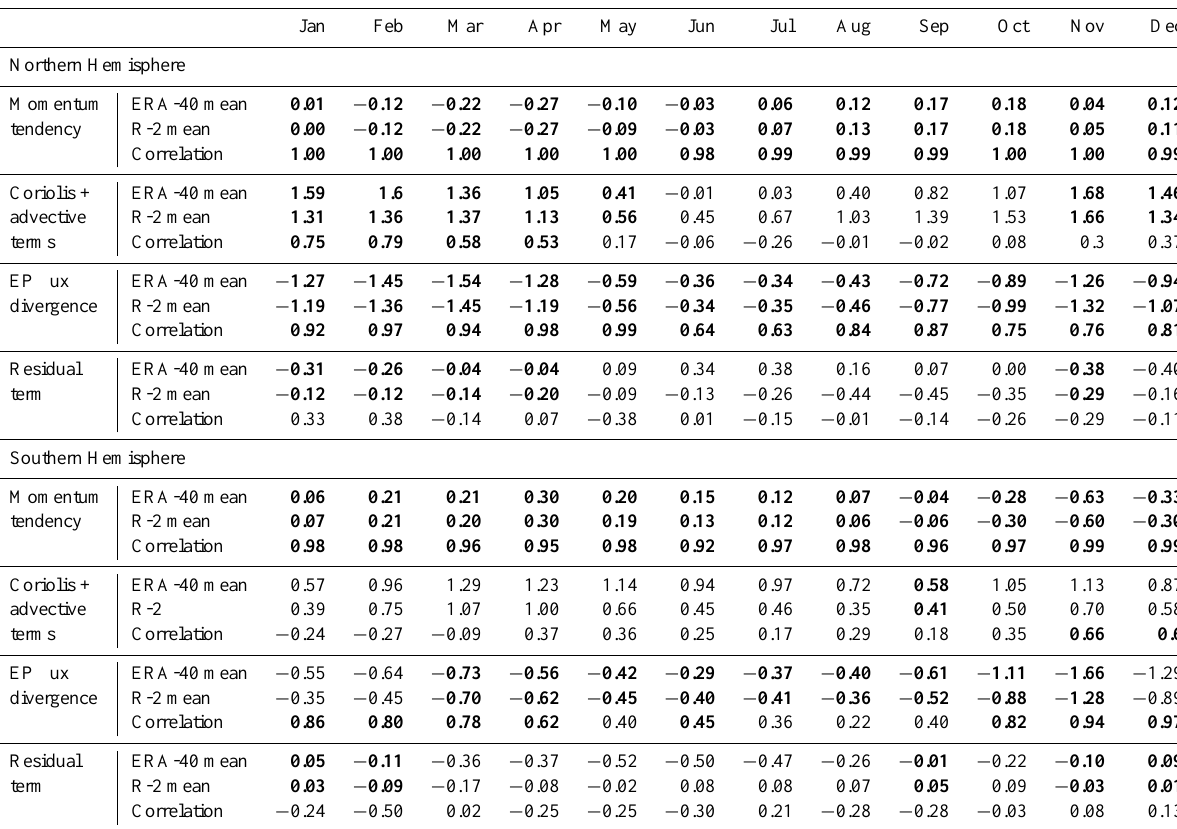
Table 1. 22-yr means and inter-dataset correlations of the momentum tendency and its forcing terms averaged between 100 and 20hPa and between 50 ◦ – 80 ◦ for the ERA-40 and R-2 reanalyses. Means that are not statistically different from each other at the 95% level based on a two-tailed Student’s t -test are bolded. Correlations that are statistically significant at the 95% level based on a one-tailed Student’s t -test are